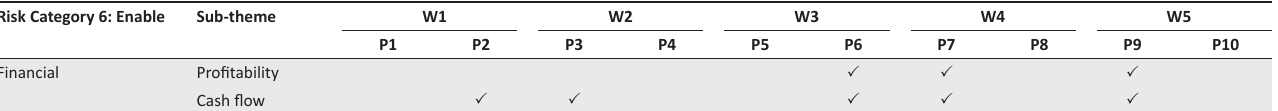
TABLE 6 : Enable risks identified by participants. Risk Category 6: Enable